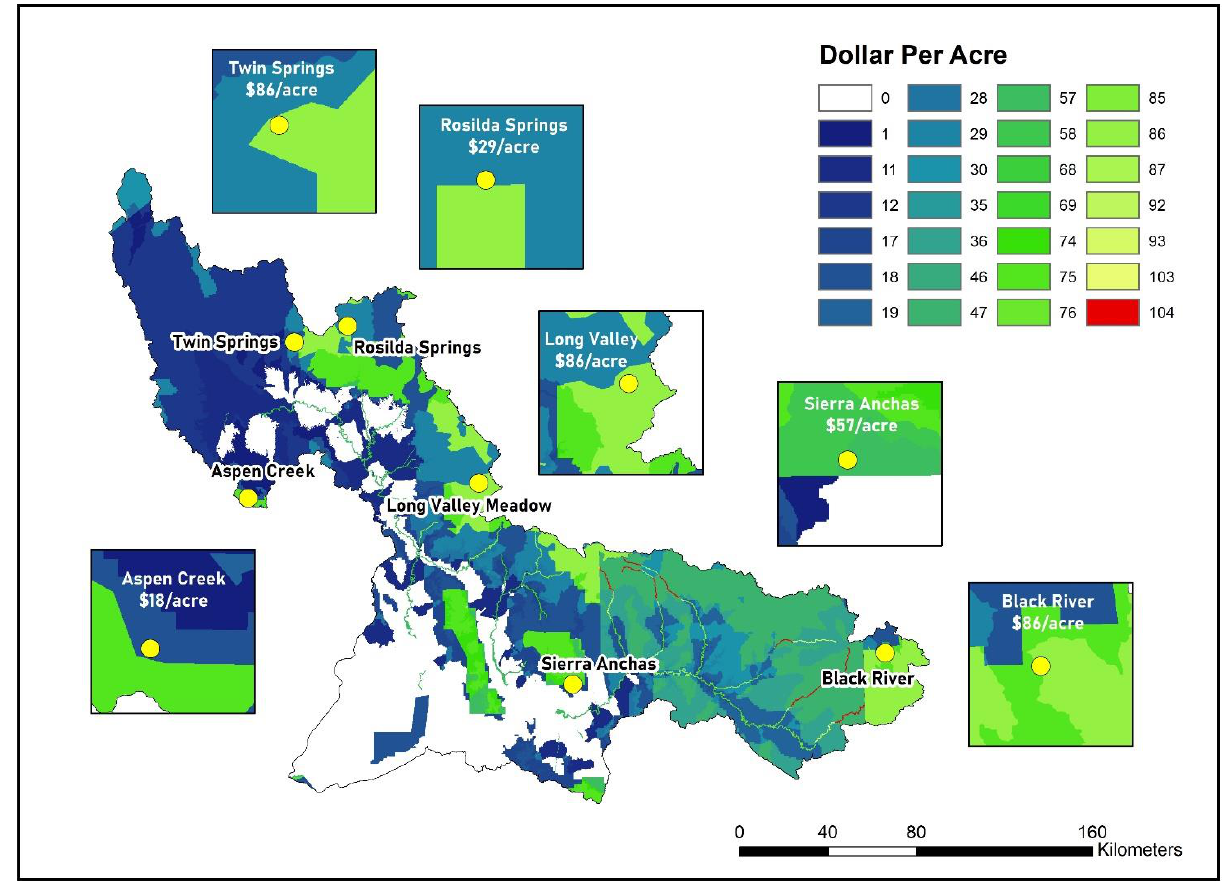
Figure 3. Benefit spatial overlay results with NAFF project locations plotted. Map layers were created using the North American 1983 Datum, GCS North American 1983, Transverse Mercator projection, and NAD 1983 State Plane Arizona Central FIPS 0202 coordinate system.